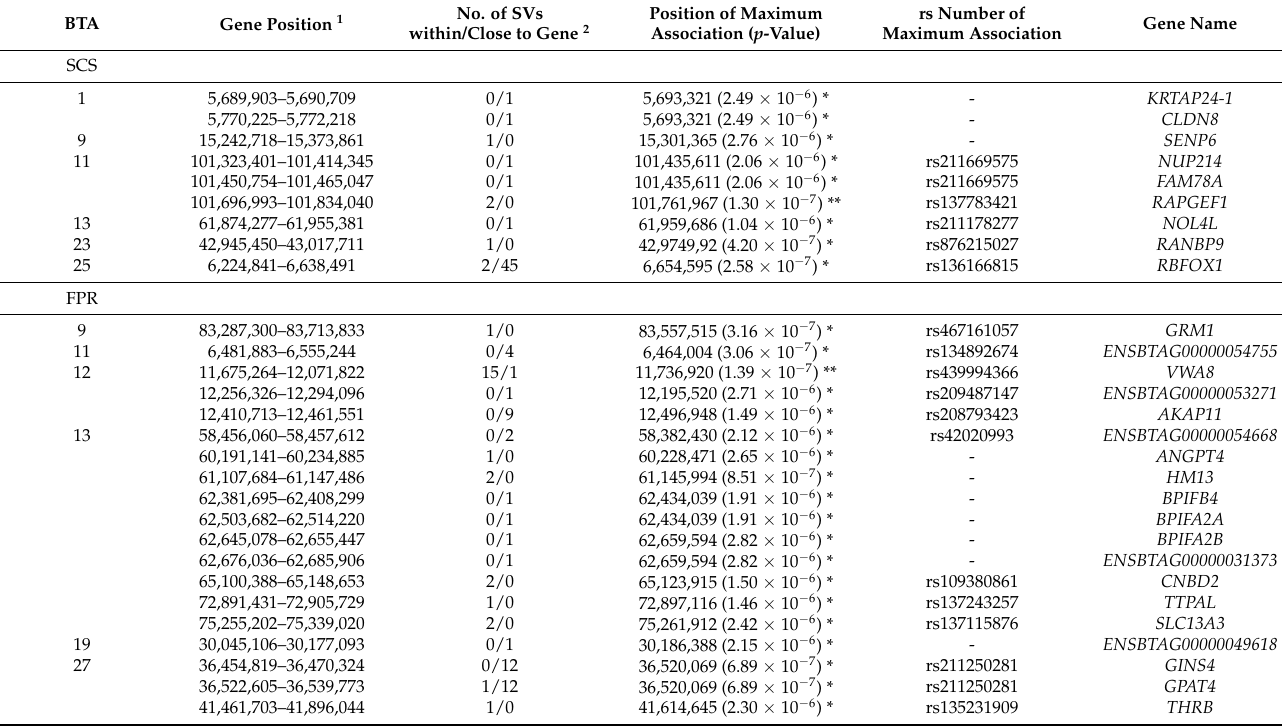
Table 3. Potential candidate genes related to the identified sequence variants (SVs) significantly associated with the udder health indicator trait somatic cell score (SCS) and with the metabolic health and stability indicator trait fat-to-protein ratio (FPR) in